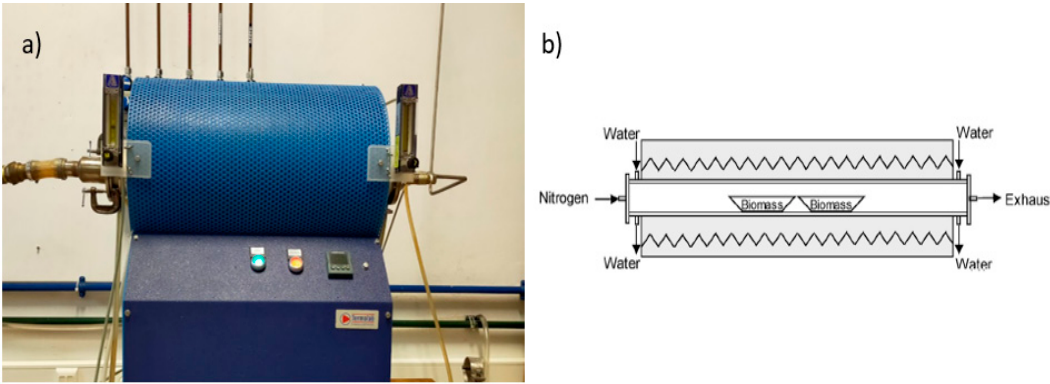
Figure 3. ( a ) Horizontal heating furnace and ( b ) reactor scheme [from